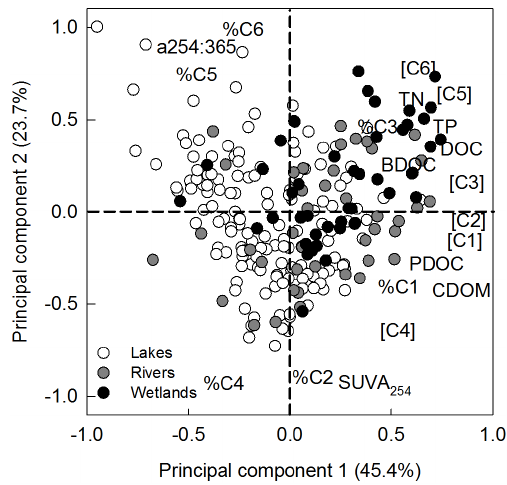
Figure 5. Principal component analysis of concentrations of degradable DOM, DOM optical properties and nutrients across bo- real lakes, rivers and wetlands. Abbreviations are defined in the text. Fluorescence components in square brackets correspond to the ab- solute concentration of the specified